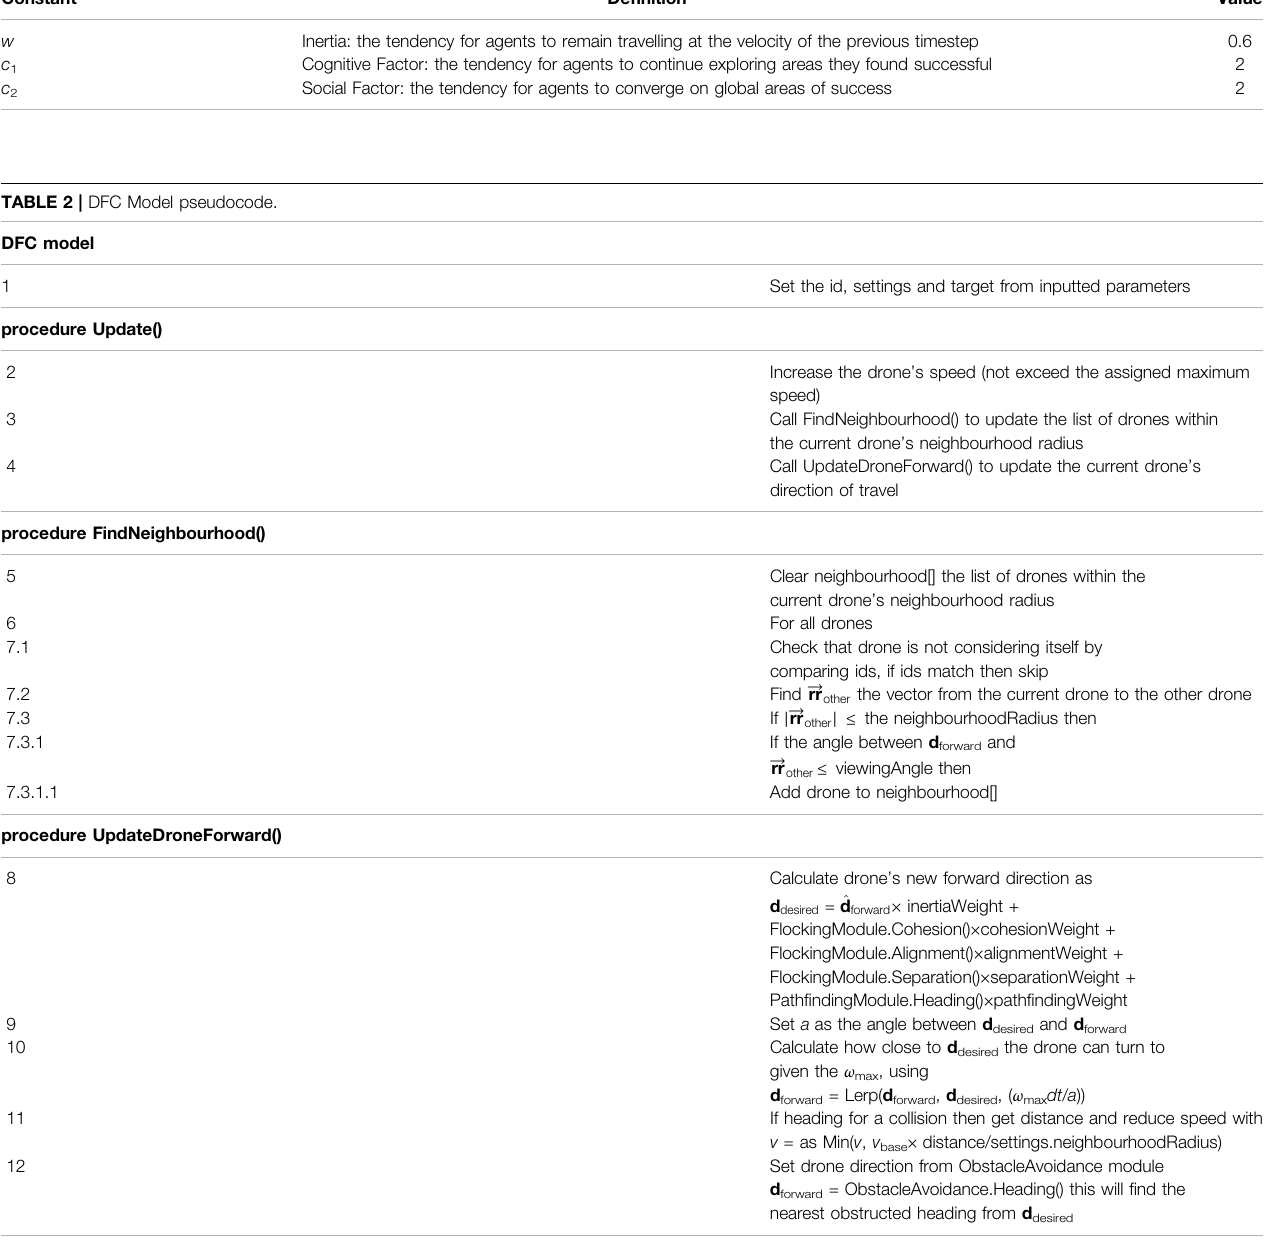
nearest obstructed heading from d